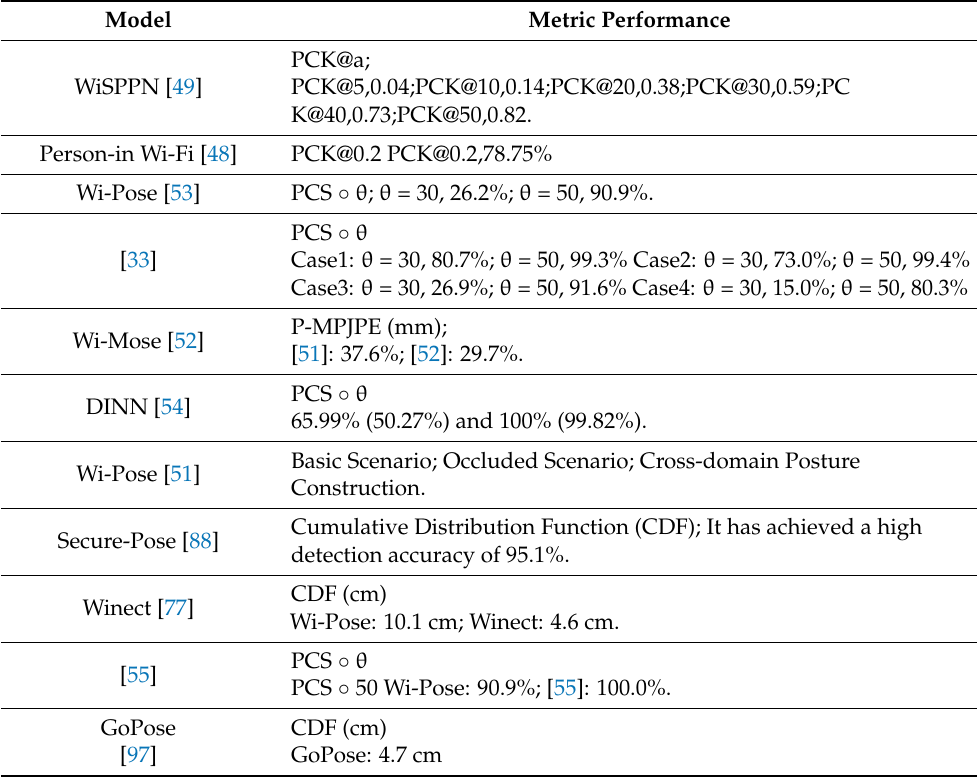
Table 5. The System Performance of HPR Based on Wi-Fi CSI.